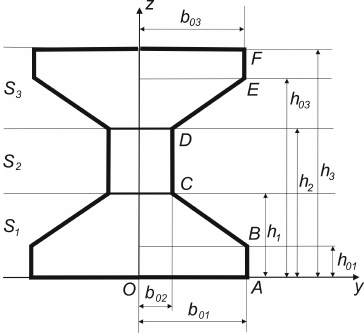
Figure 6. A cross-section of the